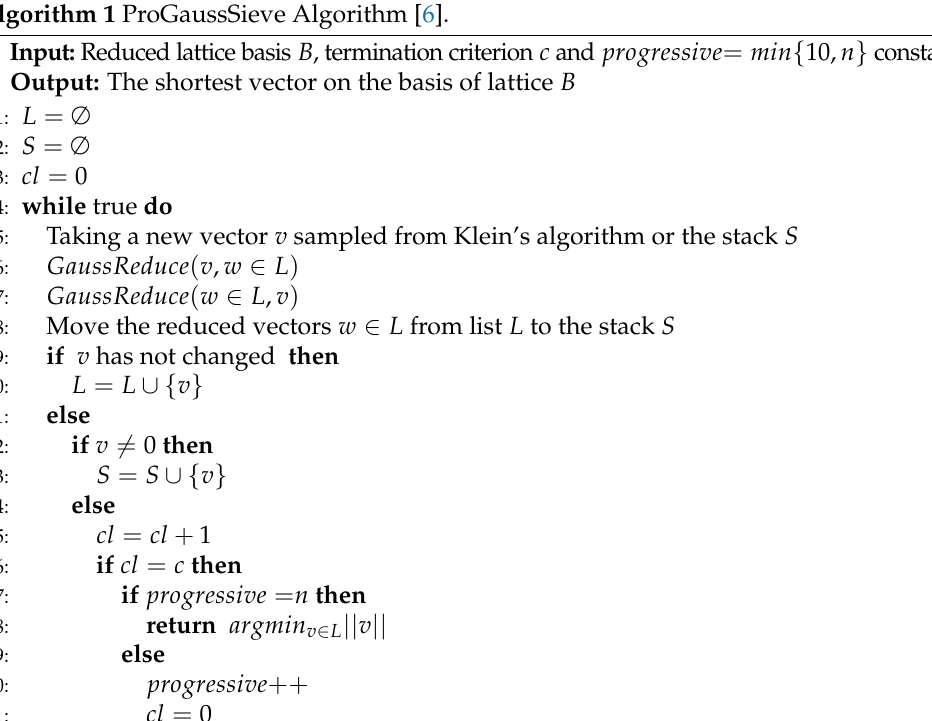
Algorithm 1 ProGaussSieve Algorithm